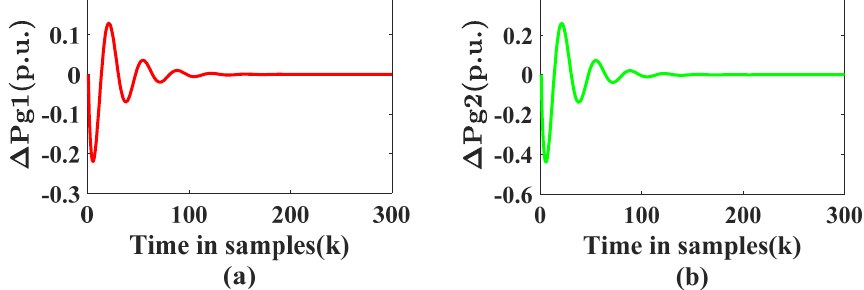
Figure 8. Output deviation signal of governor ∆ P g under the PSO-MPC strategy with wind turbines. ( a ) Output deviation signal of governor ∆ P g under ∆ P L 1 ; ( b ) Output deviation signal of governor Δ P g under Δ P L 2 .